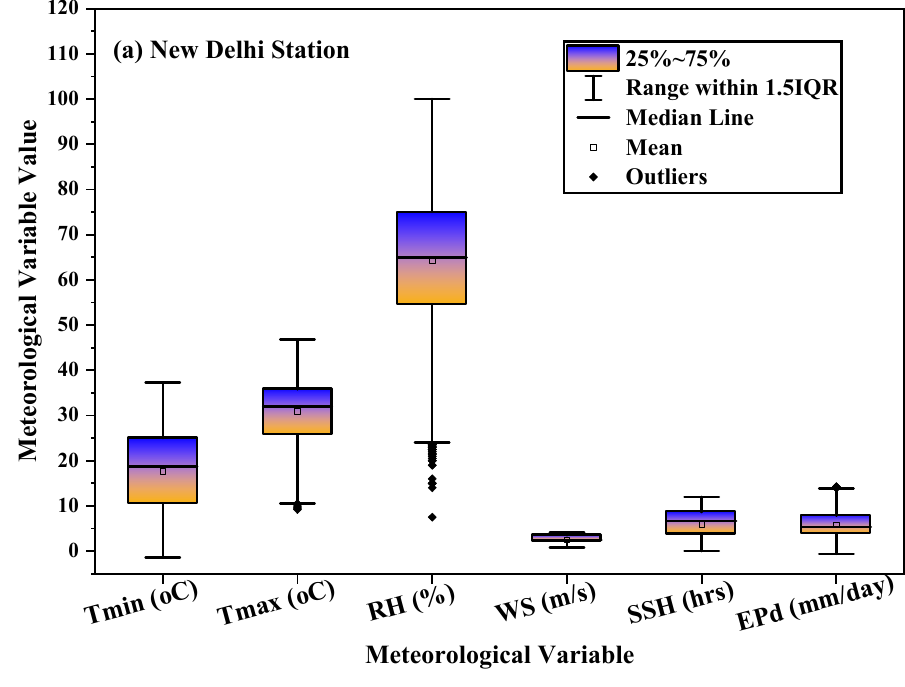
Figure 2. Standard U.S. weather bureau class A pan.